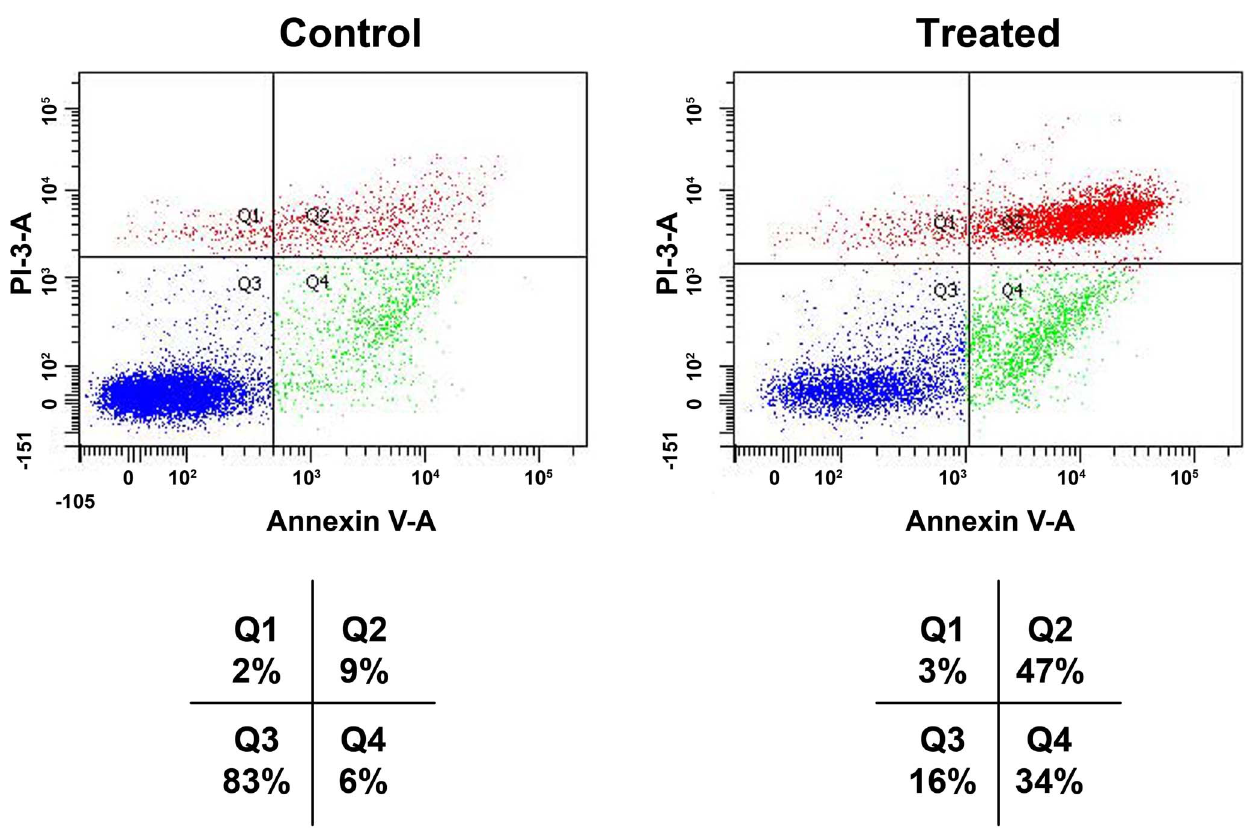
Figure 4. Effects of BP-C1 on annexin V level on T47D CELLS. Cells were treated with BP-C1 (750 m g/ml) for 48 h and Flow cytometric analysis of annexin V-FITC/PI double-stained was performed. In each plot, the lower left quadrant (Q3) represents viable cells, the upper left quadrant (Q1) indicates necrotic cells, the lower right quadrant (Q4) denotes early apoptotic cells, and the upper right quadrant (Q2) represents necrotic or late apoptotic cells.